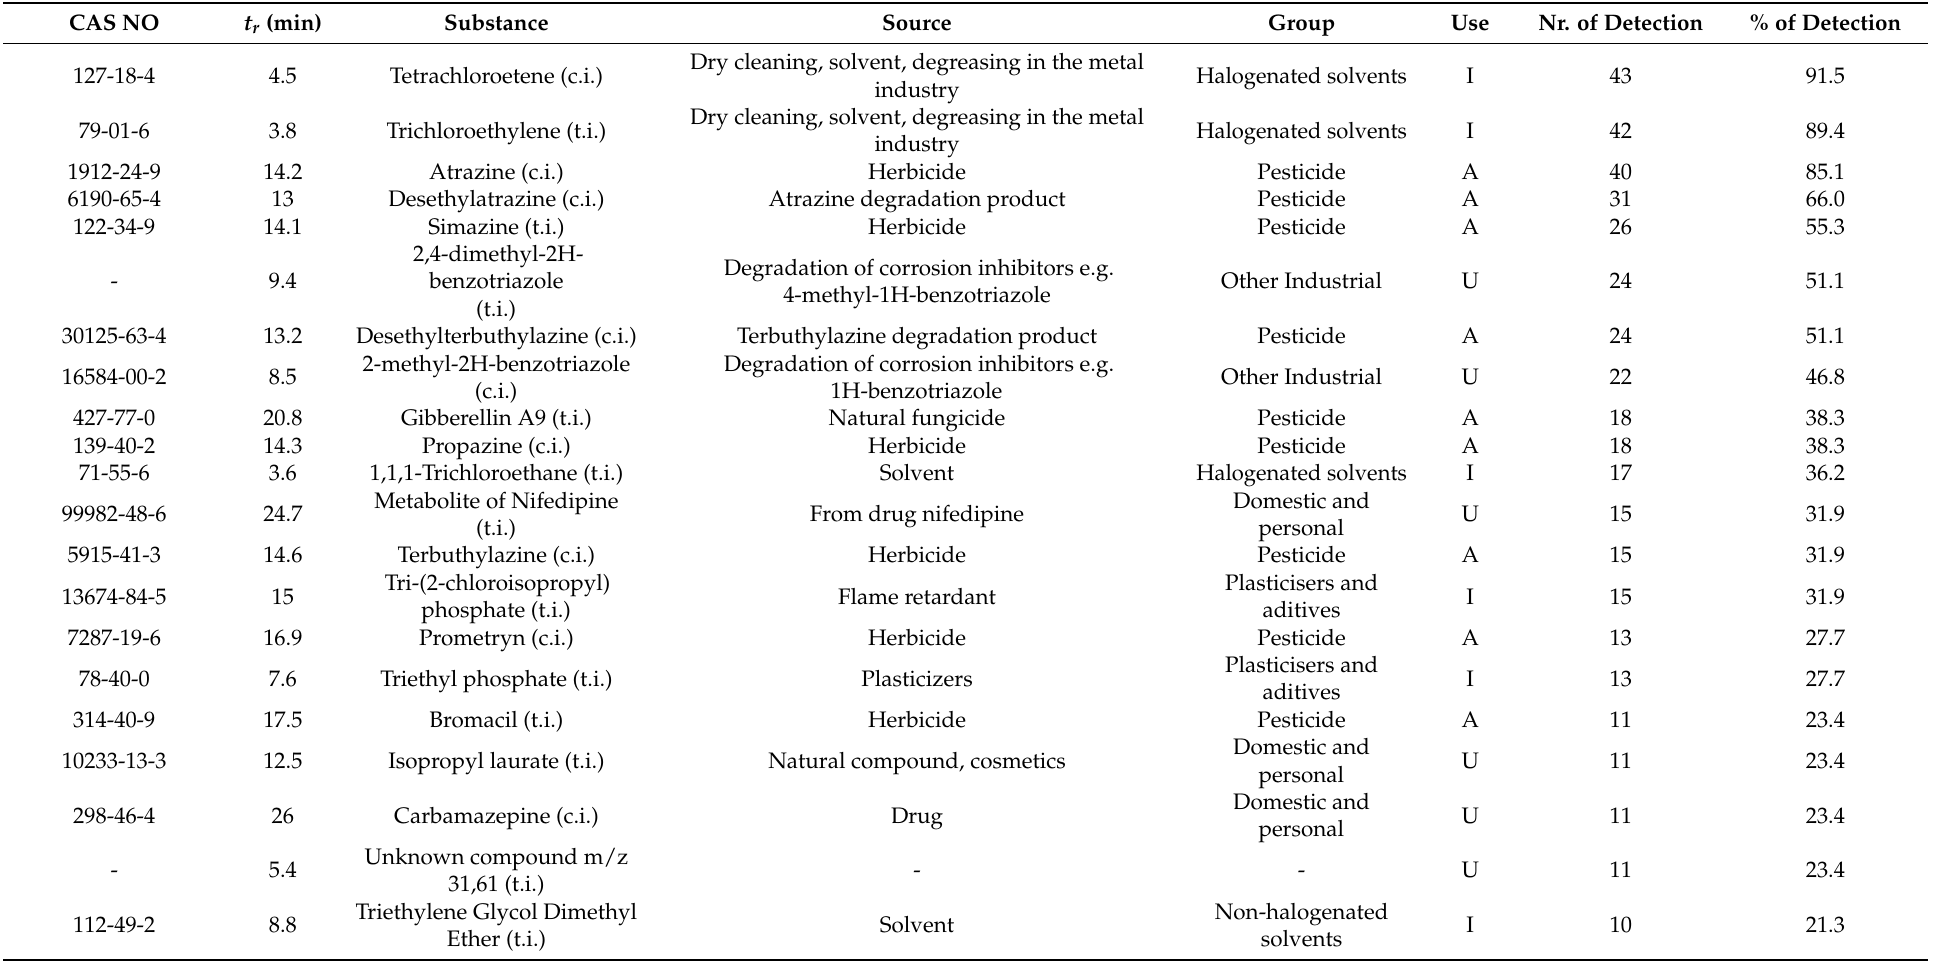
Table 4. List of selected organic compounds in groundwater, sources, and typical